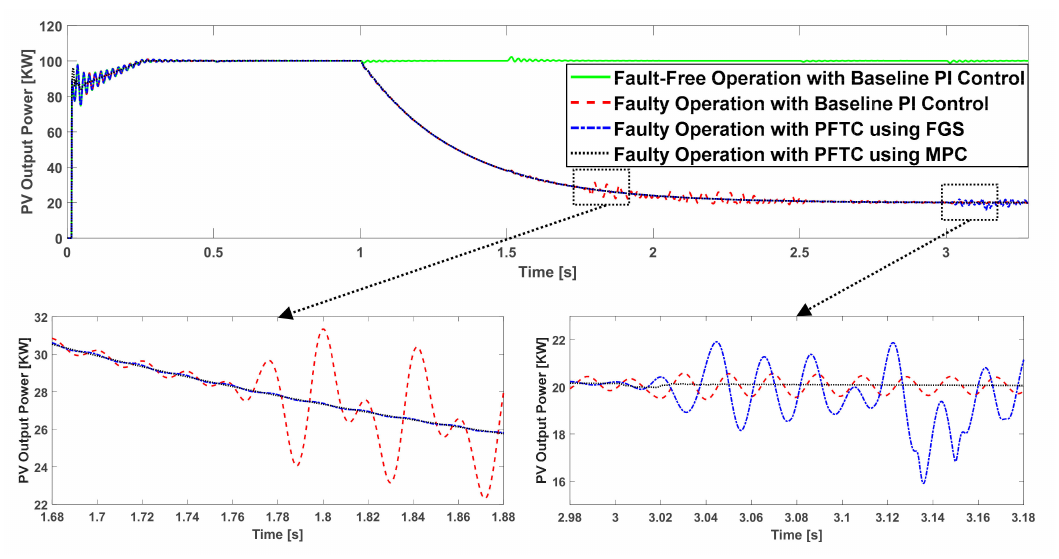
Figure 22. PV output power during fault-free and faulty operation (80% power-loss fault).